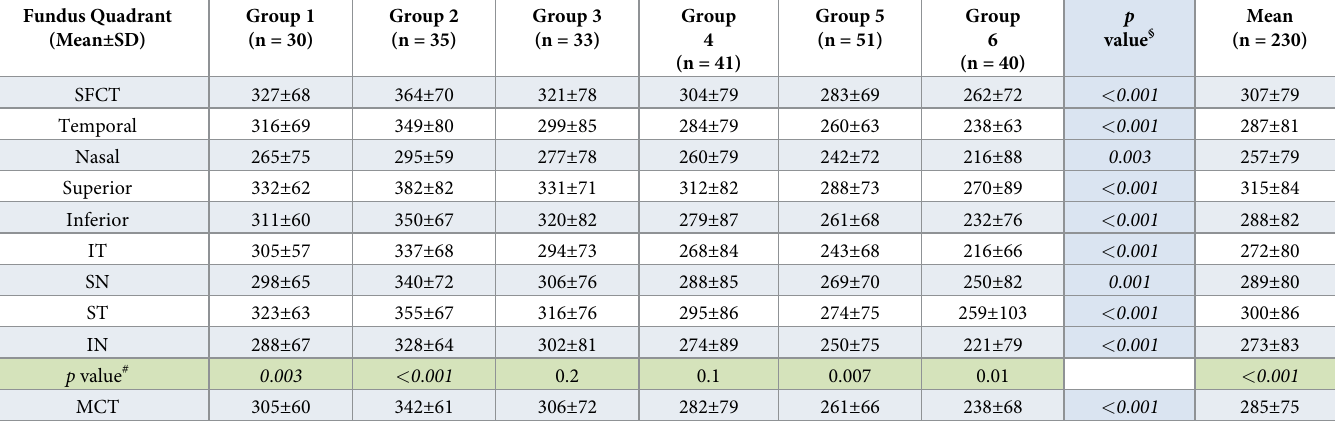
Table 3. Choroidal thickness in normal Indian subjects using SS-OCT: Mean choroidal thickness (microns) in different quadrants amongst various age groups. Fundus Quadrant (Mean ±